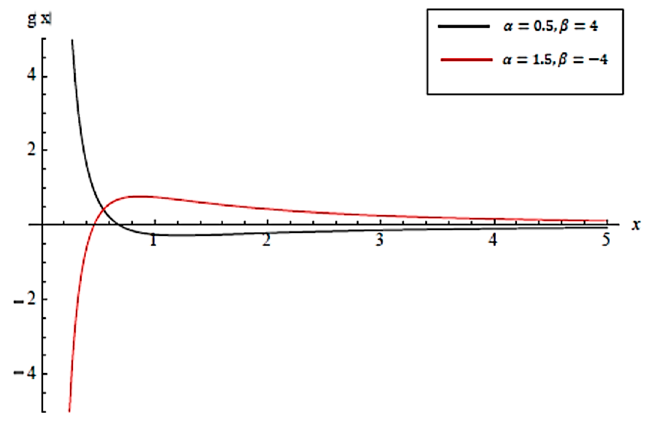
Therefore, 𝑓(𝑥) is neither log-convex nor log-concave.